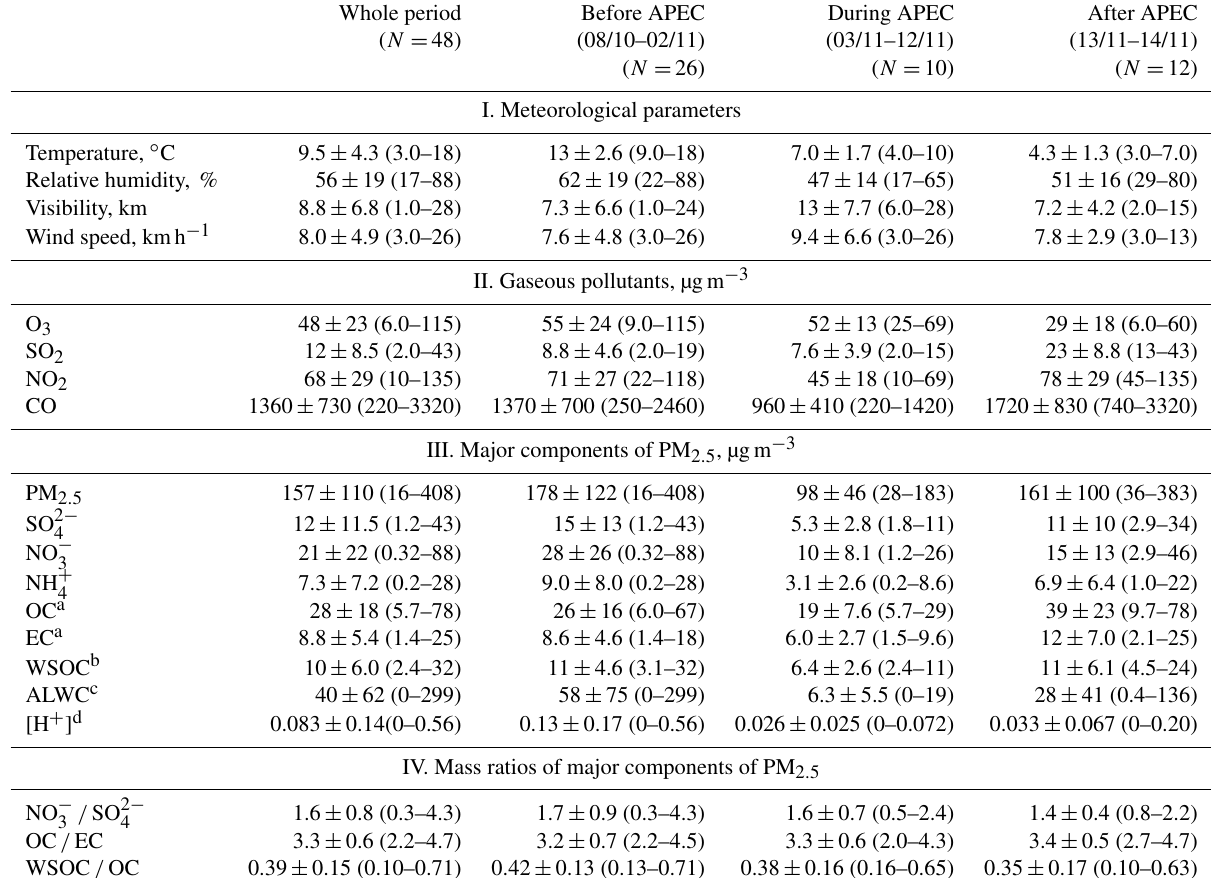
Table 1. Meteorological parameters and concentrations of gaseous pollutants and chemical components of PM 2 . 5 in Beijing during the 2014 APEC